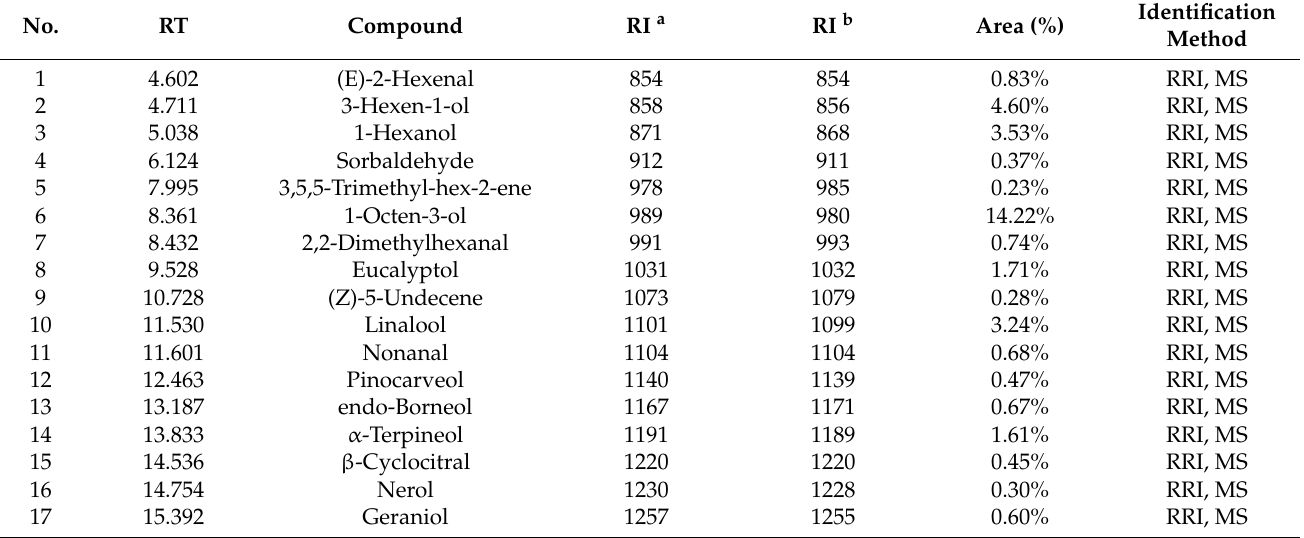
method in detail in the EOs of T. triquetrum (L.) Ohashi. Table 1. Chemical composition of EOs distilled from T. triquetrum (L.) Ohashi. Table 1. Chemical composition of EOs distilled from T. triquetrum (L.)